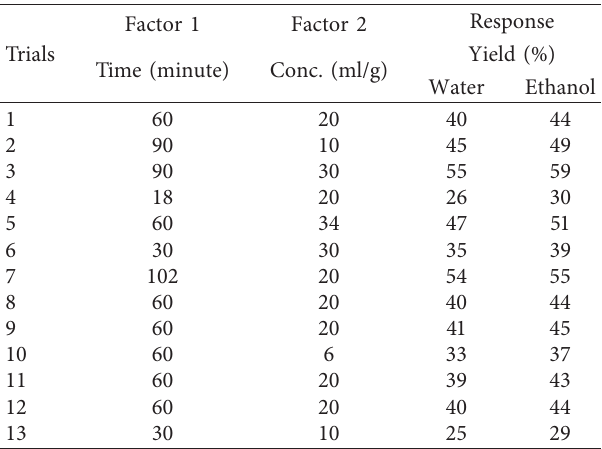
Table 2: Number of runs by using central composite design (CCD) and their